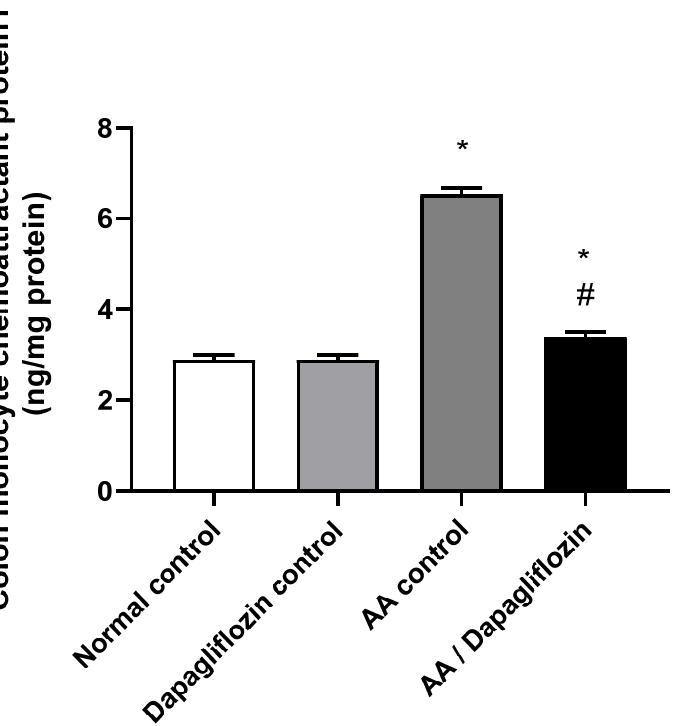
Figure 4. Effect of DAPA on AA-induced change in Monocyte chemoattractant protein(MCP1) in colon tissue. Data are expressed as mean ± SEM. Statistical analysis was performed using one-way ANOVA followed by the Tukey–Kramer multiple comparison test ( p < 0.05). Superscript letters refer to the level of significance: * DAPA significantly different from the normal control group; # DAPA significantly different from the AA control group).